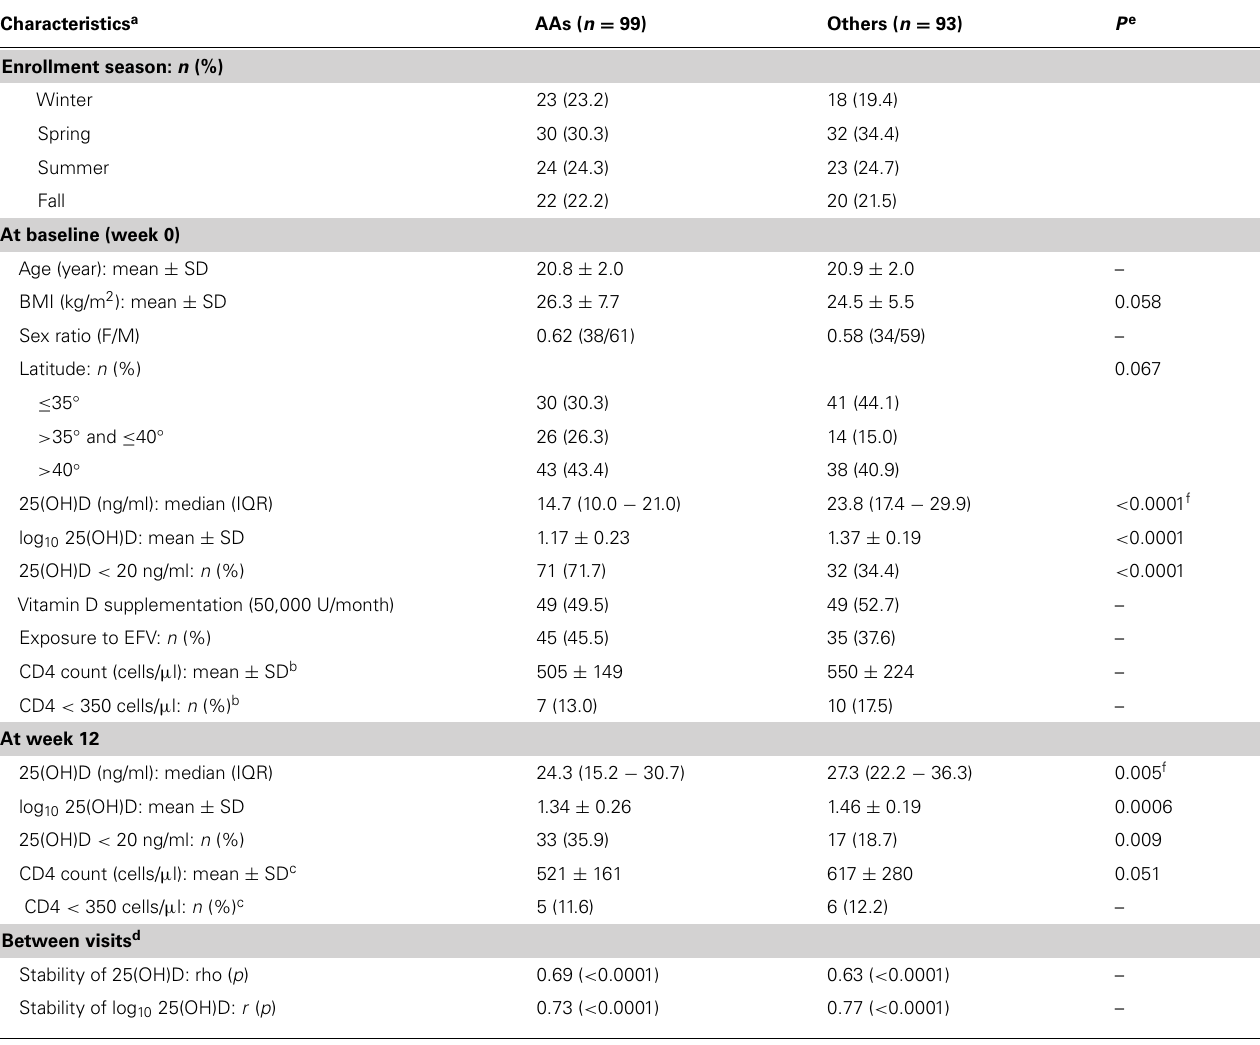
Table 1 | Main characteristics of the study population, after stratification by